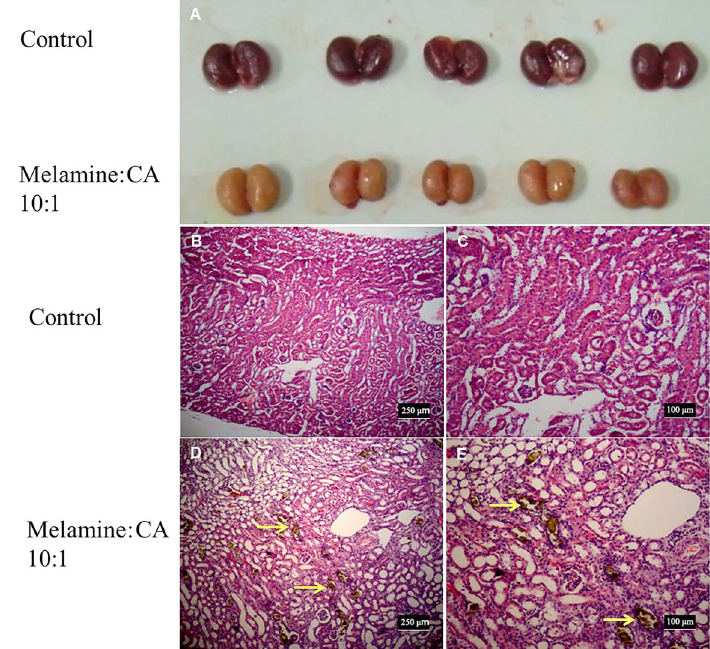
Figure 5. Effects of dietary co-exposure to melamine and cyanuric acid (CA) (10:1) on the morphological ( A ) and histological appearance of the kidney of mice. Representative photographs of histological examination for the 2 groups are shown in B to E . Golden- brown colored crystals (yellow arrow) were observed in renal tubules in the mice of experimental groups ( D and E ). Scale bars: 250 m m (B and D) and 100 m m (C and